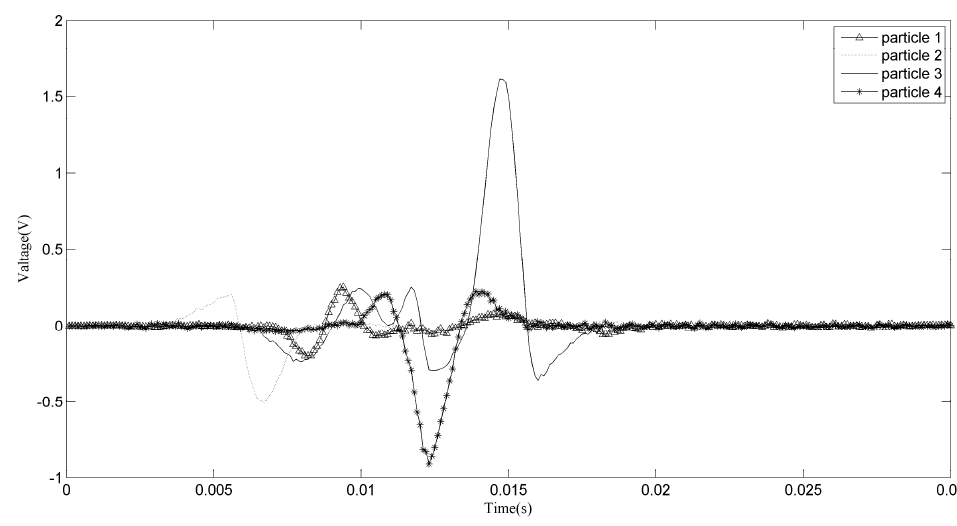
Figure 14. Demixing result of section a2 into four particles.